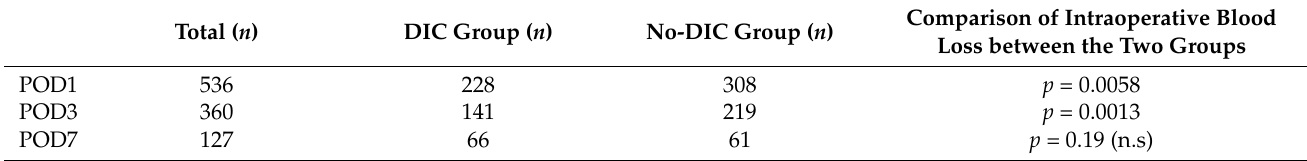
Table 4. Incidence of cardiovascular surgery-associated DIC.